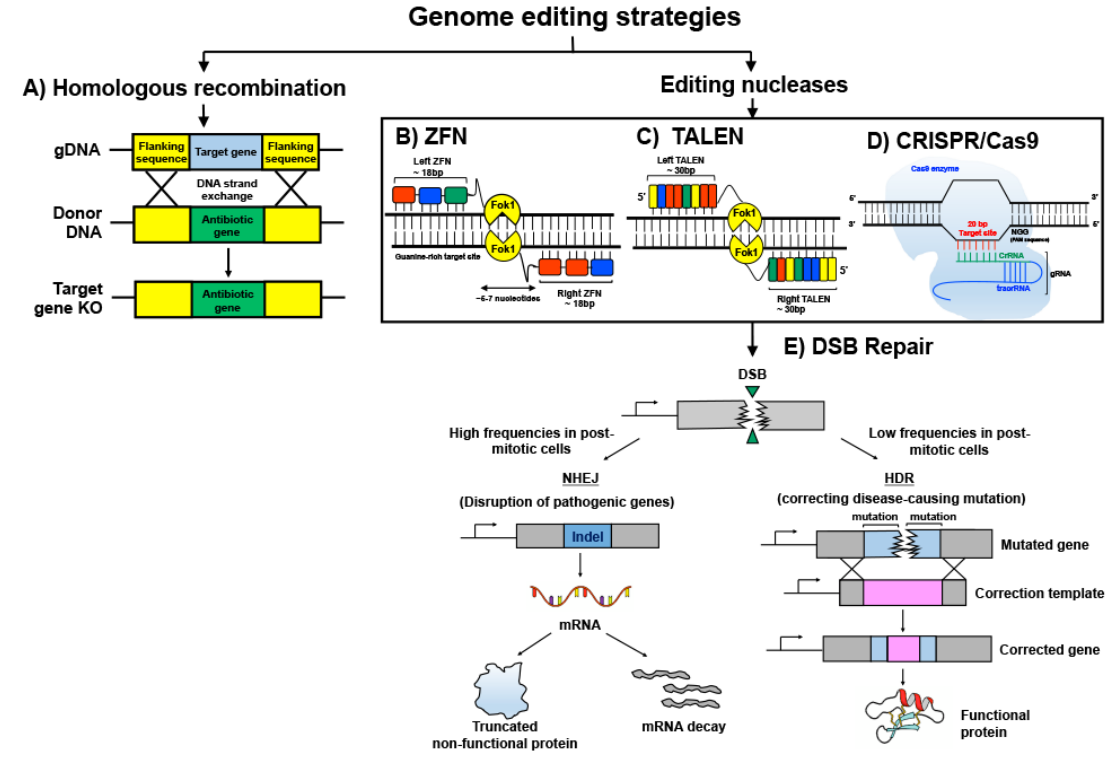
Figure 1. Genome editing strategies. Genome editing technologies can be employed using non- enzymatic and enzymatic methods. ( A ) Homologous recombination is a process whereby DNA strand exchange occurs between two homologous DNA molecules. The antibiotic gene in the donor DNA serves as a selection marker to ascertain the knockout of the target gene in the cell. ( B ) Zinc finger modules are linked together in tandem using conserved linker sequences to recognize target sequences that are composed of DNA triplets. Fok1 nuclease is fused to the zinc finger array. ( C